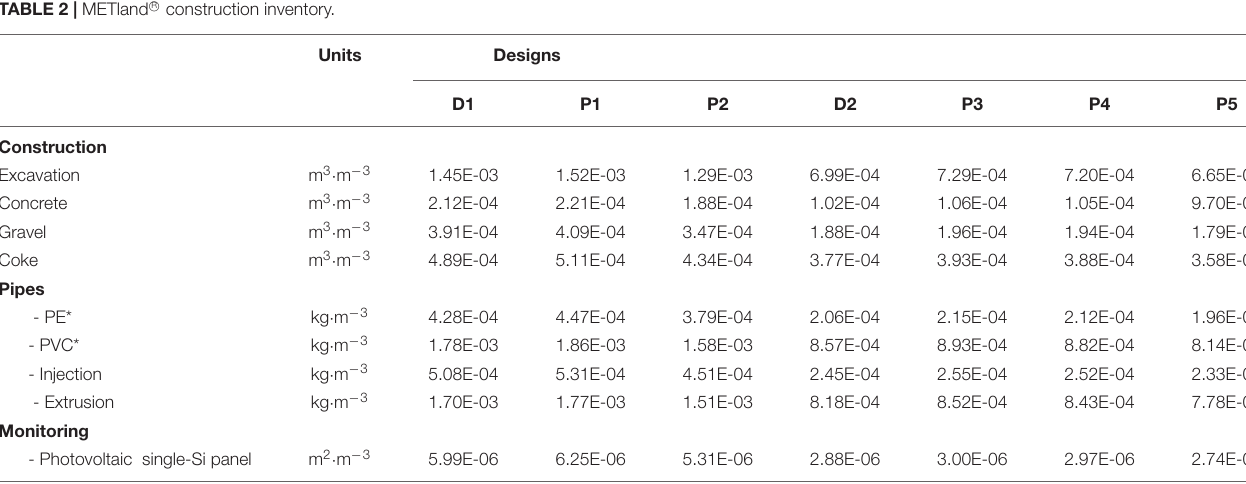
TABLE 2 | METland R (cid:13) construction